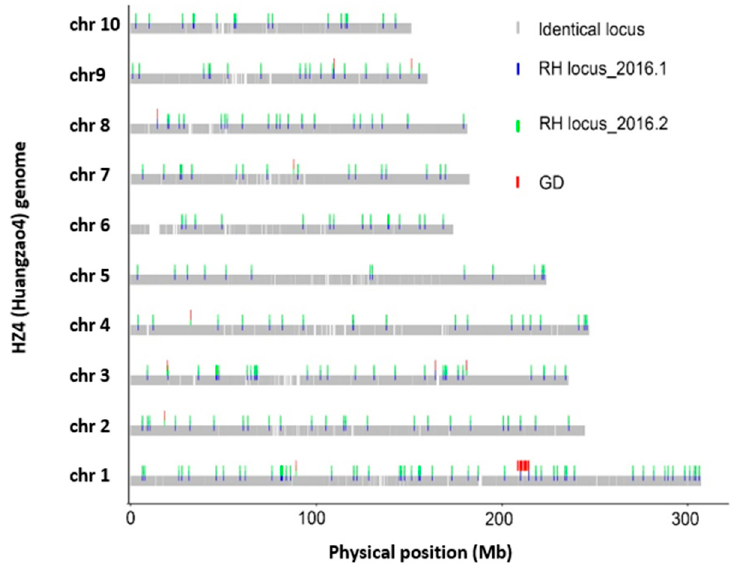
Figure 2. Region distribution of residual heterozygosity (RH) and genetic drifts (GD) between two HZ4 accessions of year 2016 across whole physical genome. An identical locus is a homozygous SNP and is the same in the two HZ4 accessions. A GD locus is a homozygous SNP but is different between the two HZ4 accessions.